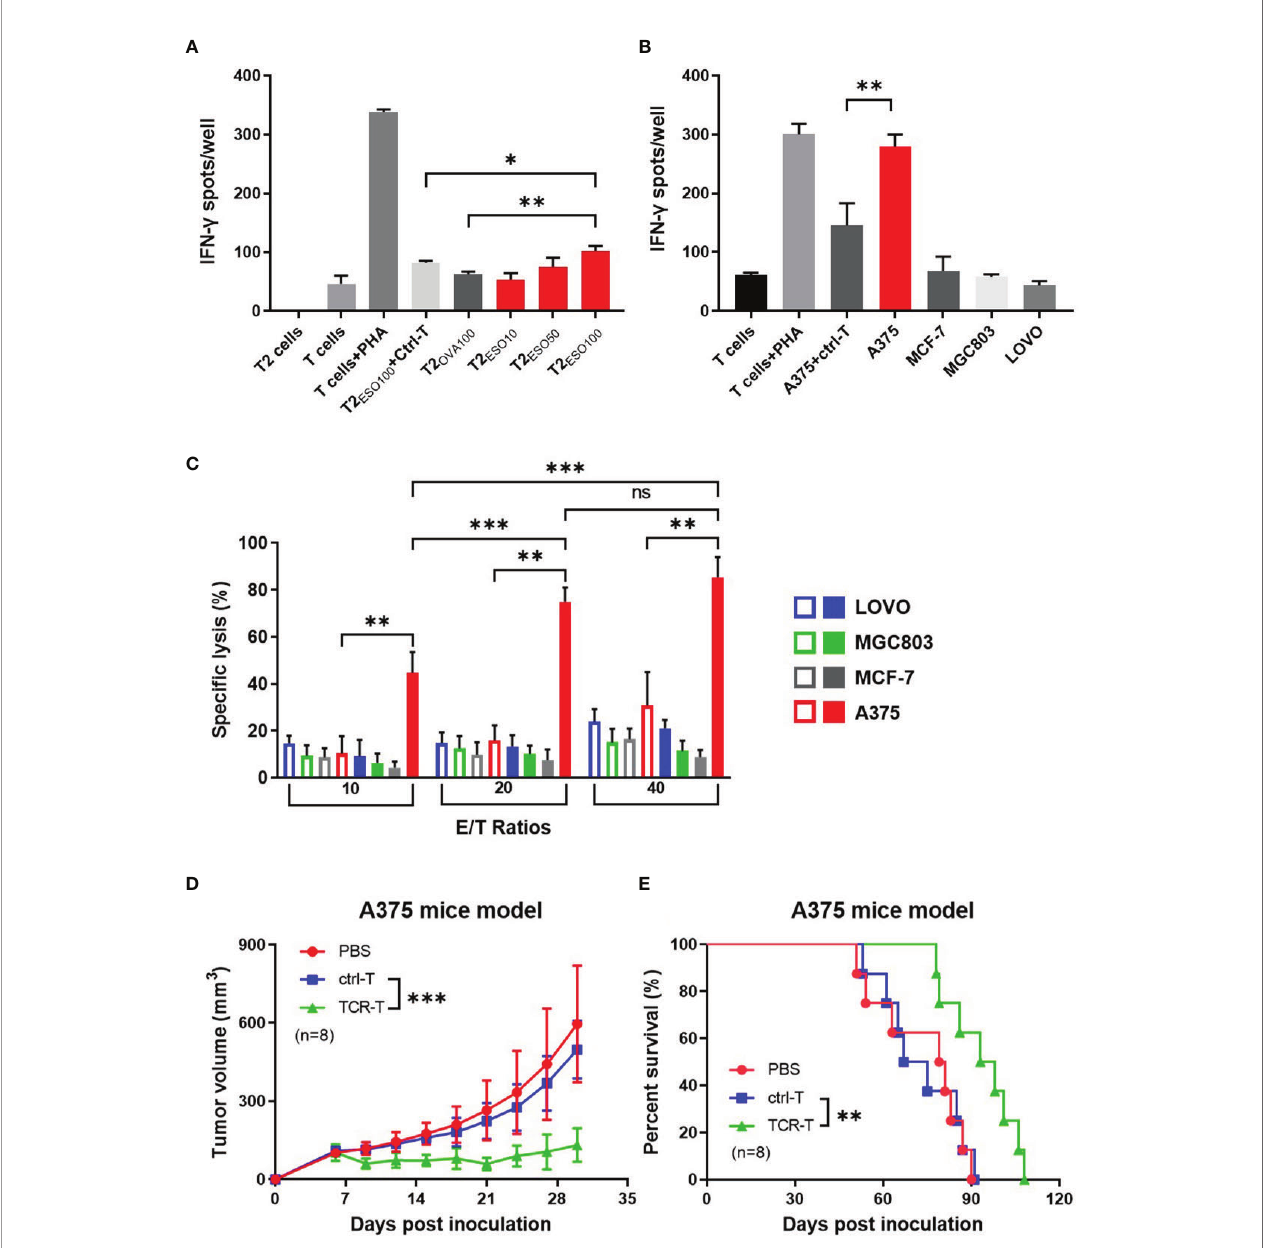
FIGURE 2 | In vitro and in vivo speci fi c cytotoxicity of the NY-ESO-1 TCR-T cells. (A) IFN- g ELISPOT assay: T cells transduced with mock gene were used as ctrl-T cells, and the NY-ESO-1 TCR-T cells as effectors. T cells were co-cultured with T2 cells, which were used as stimulators, and loaded with different concentrations of cognate antigens, respectively. The unloaded T2 cells alone and T cells alone served as background controls, while the T cells+PHA served as a positive control. ESO10/50/100 indicated the concentration of antigens at 10 ng/ml, 50 ng/ml, 100 ng/ml NY-ESO-1 peptides (p157-165) respectively, and OVA100 indicated 100 ng/ml irrelevant OVA peptides (p257-264). The effector-stimulator ratio was 20:1 in this experiment. Spots of IFN- g were counted and analyzed. PHA: Phytohaemagglutinin, a selective T cell mitogen for T cell activation. *P<0.05. **P<0.01. (B) IFN- g ELISPOT assay: ctrl-T cells or the NY-ESO-1 TCR-T cells were co-cultured with tumor cells expressed different genotypes of HLA-A2 and NY-ESO-1, which served as stimulators. The T cells alone and tumor cells alone (not shown) served as background controls, while the T cells+PHA served as a positive control. The effector-stimulator ratio was 20:1 in this experiment. The spots of IFN- g were counted and analyzed. (C) LDH assay: ctrl-T cells (empty column) and the NY-ESO-1 TCR-T cells (full column) were used as effectors and the tumor cells with different genotypes of HLA-A2 and NY-ESO-1 were used as targets. The effectors(E) and targets(T) were co-cultured at different E/T ratios as indicated. Spontaneous release of target cells was less than 20%. Results shown were mean ± SD of quadruplicate wells. ns: no signi fi cance. **P<0.01; ***P<0.001. (D) Antitumor effects of the TCR-T cells on A375 xenograft nude mice. The PBS, ctrl T cells or the TCR-T cells were infused three times weekly via tail vein. The tumor size was measured every three days. Bars, mean ± SD. *** P <0.001. (E) Kaplan-Meier survival plot. The survival curve was analyzed by log-rank test. ** P =